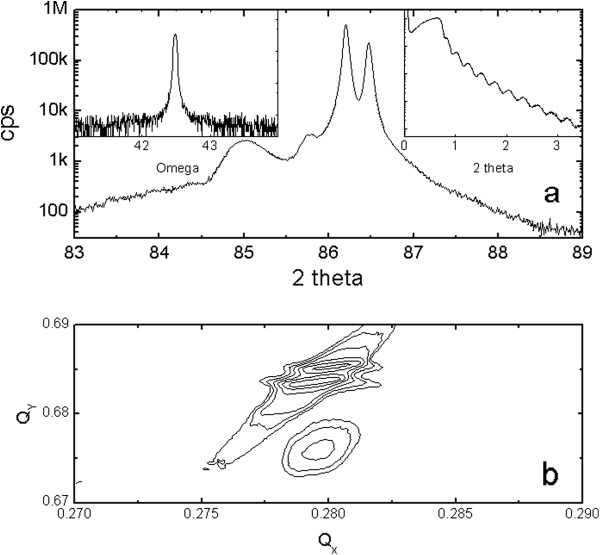
HRXRD results for the SrRuO3/SrTiO3 (111) substrate. (a) XRD θ to 2θ scan patterns. The left inset shows the rocking curve of the SrRuO3 (222) peak. FWHM was as small as 0.052°. The right inset shows good oscillations at low angles due to the uniform thickness of about 38 nm. (b) X-ray reciprocal space mapping around the STO (312) plane showed well-developed peaks for SrRuO3 in the lower region and two strong substrate peaks in the upper region.